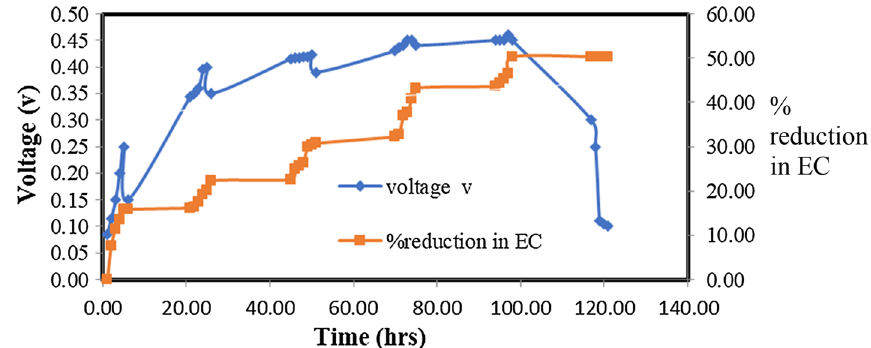
Fig. 3 Voltage versus reduction percentage in